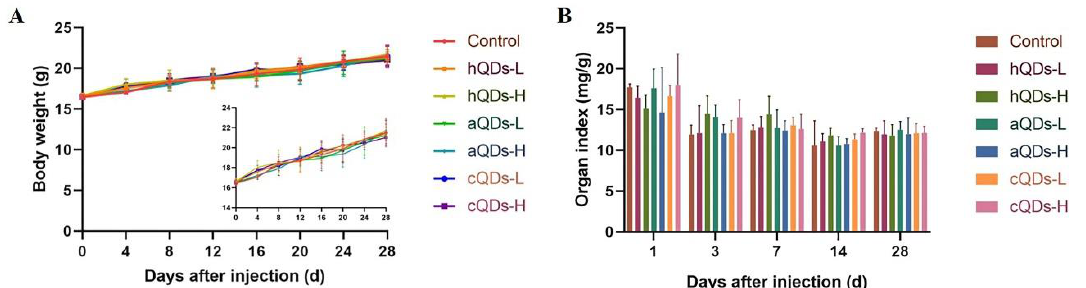
Figure 2. Body weight and kidney organ index in mice administered with 25 mg/kg BW QDs (H) or 2.5 mg/kg BW QDs (L). ( A ) The body weight curve of mice measured continuously for 28 days (Insert: magnified state of the body weight curve). ( B ) The kidney weight/BW coefficients of mice at different predetermined time points.